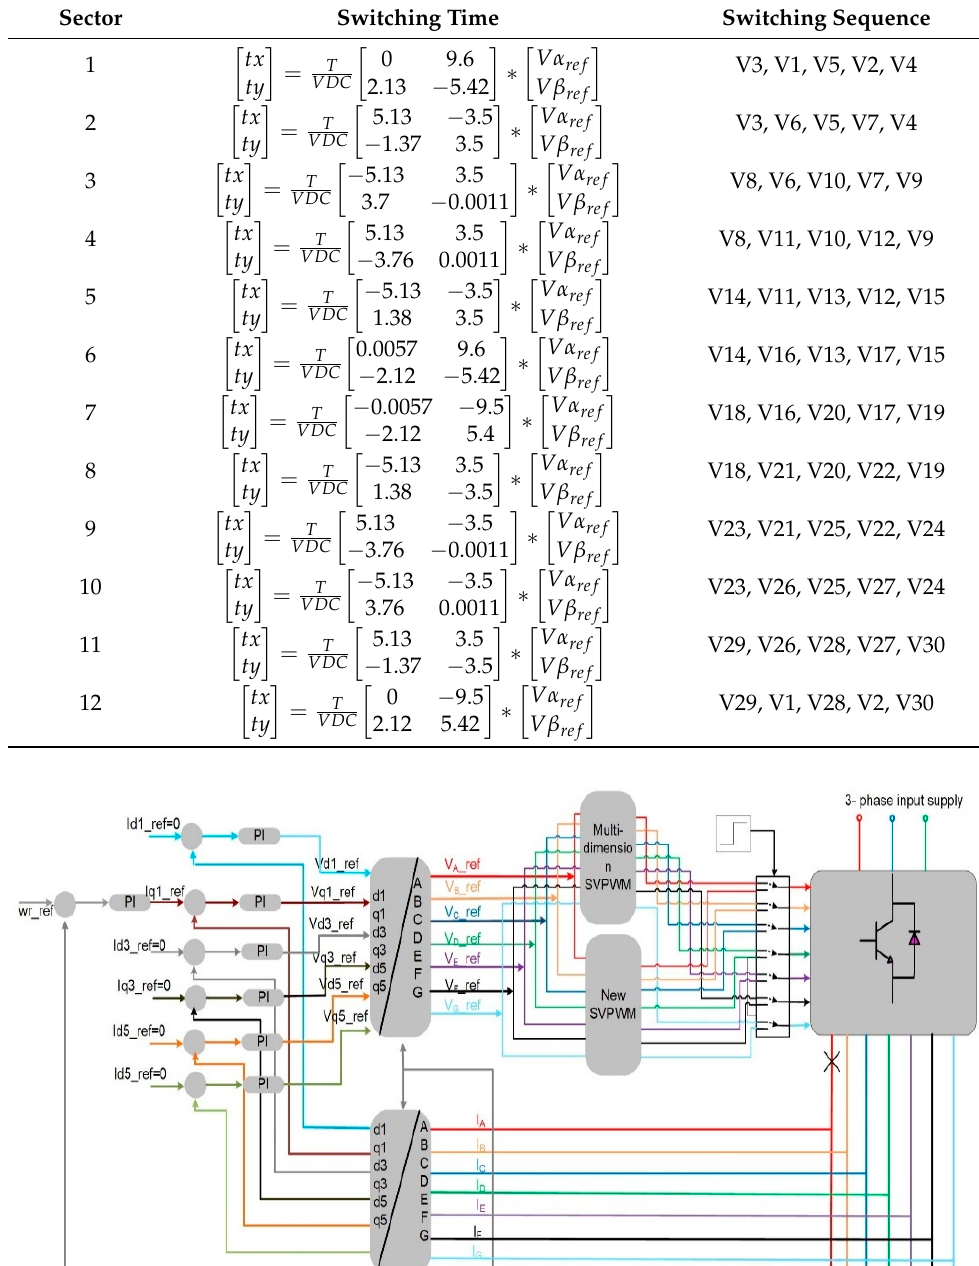
Table 2. Dwell time calculation and switching sequence of the active vectors in the new SVPWM.